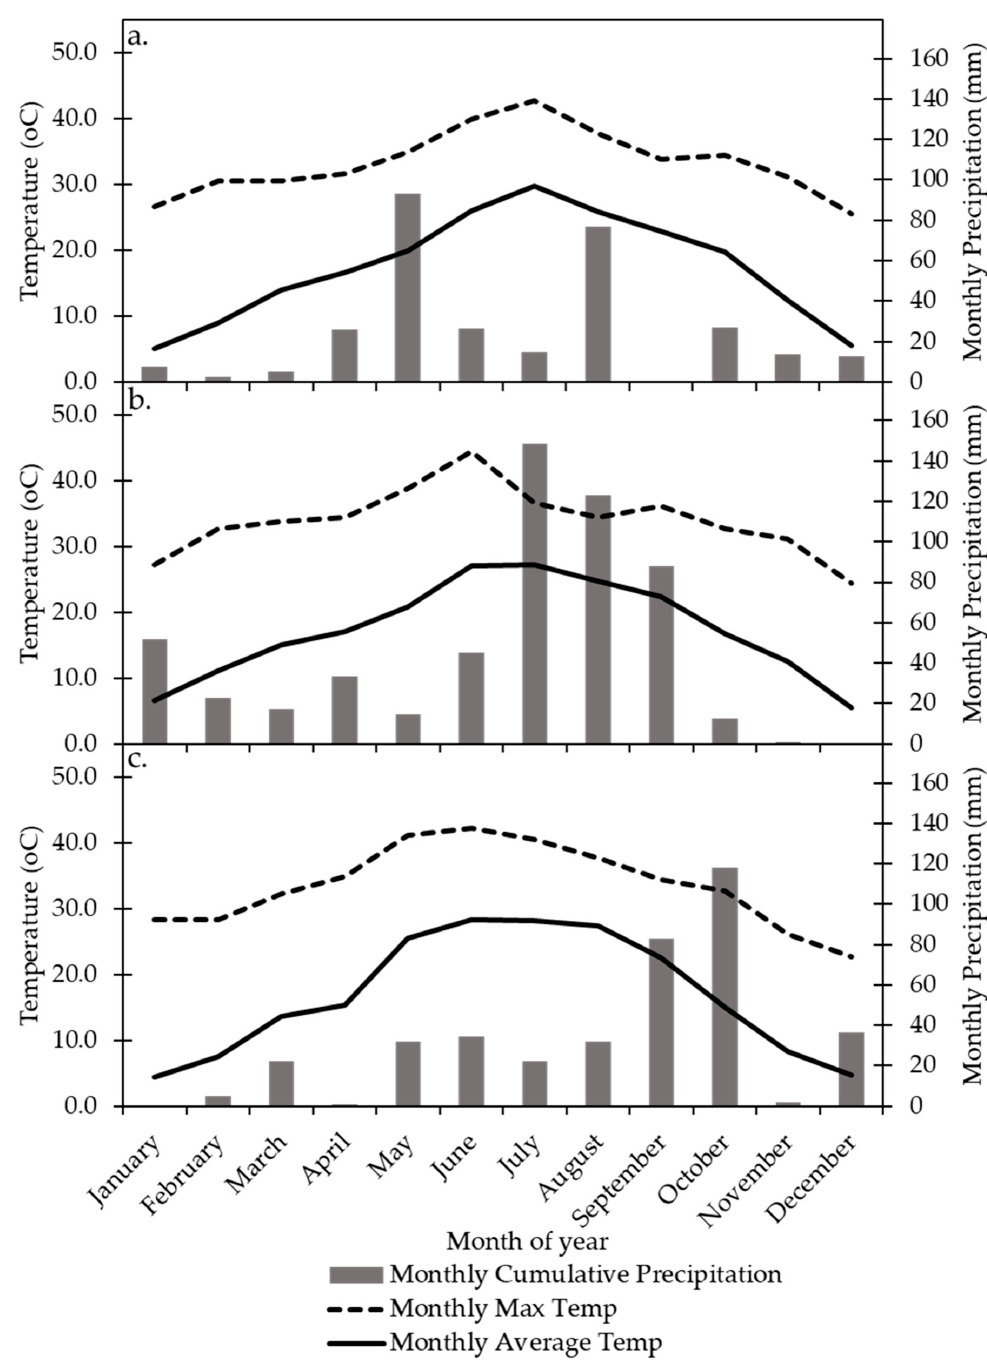
Figure 1. Maximum monthly temperatures, average monthly temperatures and monthly cumulative precipitation at the Lubbock International Airport (33.6656°, − 101.8231°) located 1 km south of